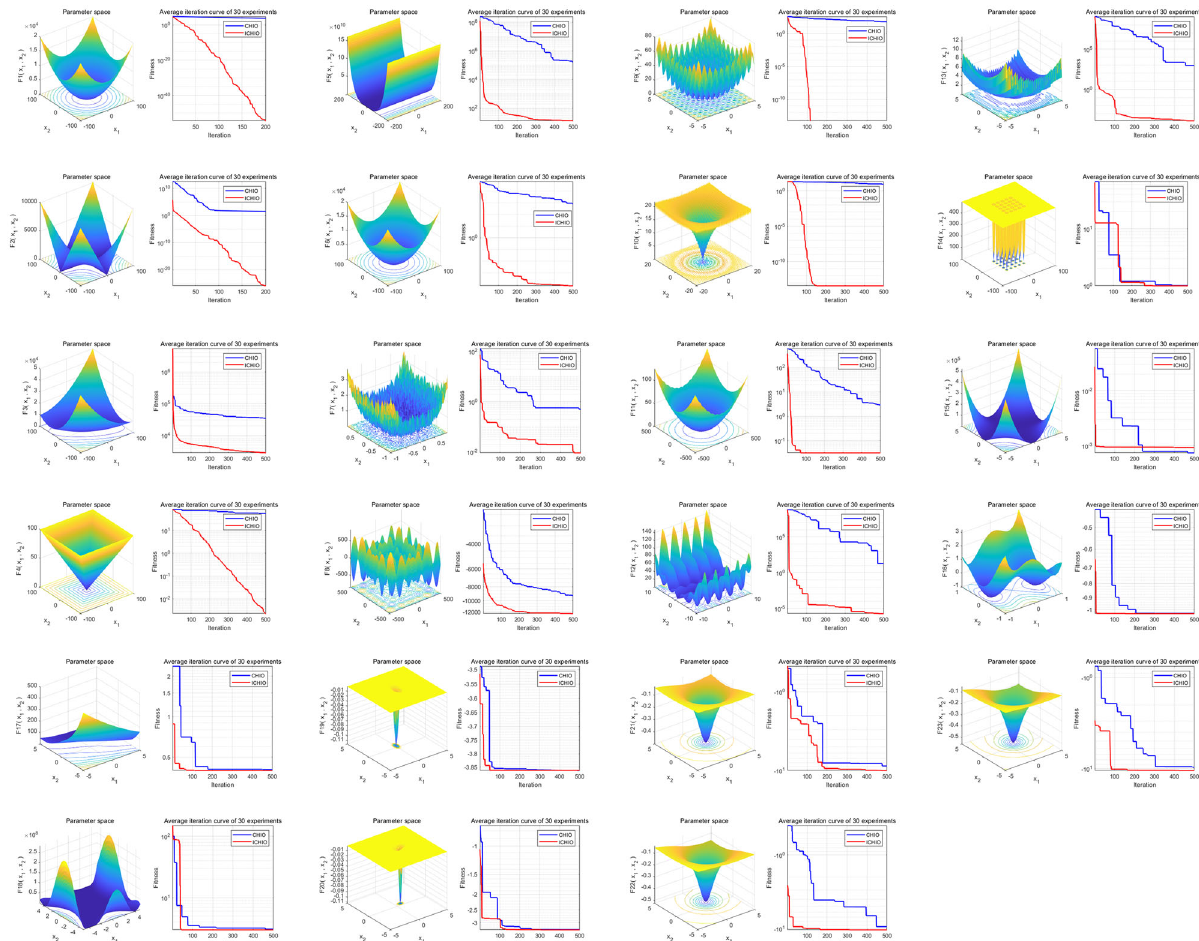
Fig. 12 Functions and convergence plots. When using the ICHIO algorithm, the three-dimensional surface diagram in the fi gure shows the two-dimensional search space of each benchmark function. The line chart shows the convergence trend of the fi rst solution of the fi rst dimension of each benchmark function and compares the trends of the CHIO and ICHIO